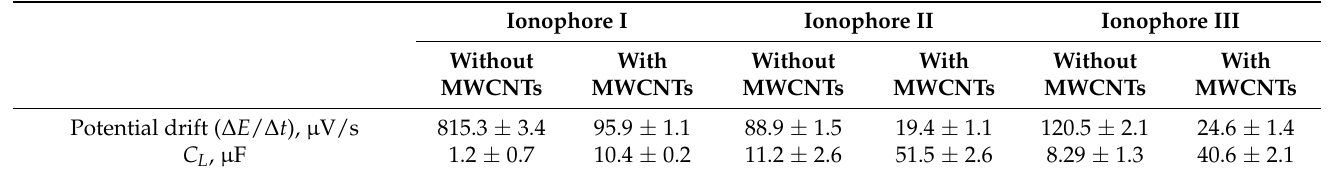
Figure 5. Current reversal chronopotentiometry for ( a ) non-modified and ( b ) modified FLX-ISEs based on ionophores I, II, and III. Table 4. Potential drifts and double-layer capacitances for the presented sensors in the presence and absence of